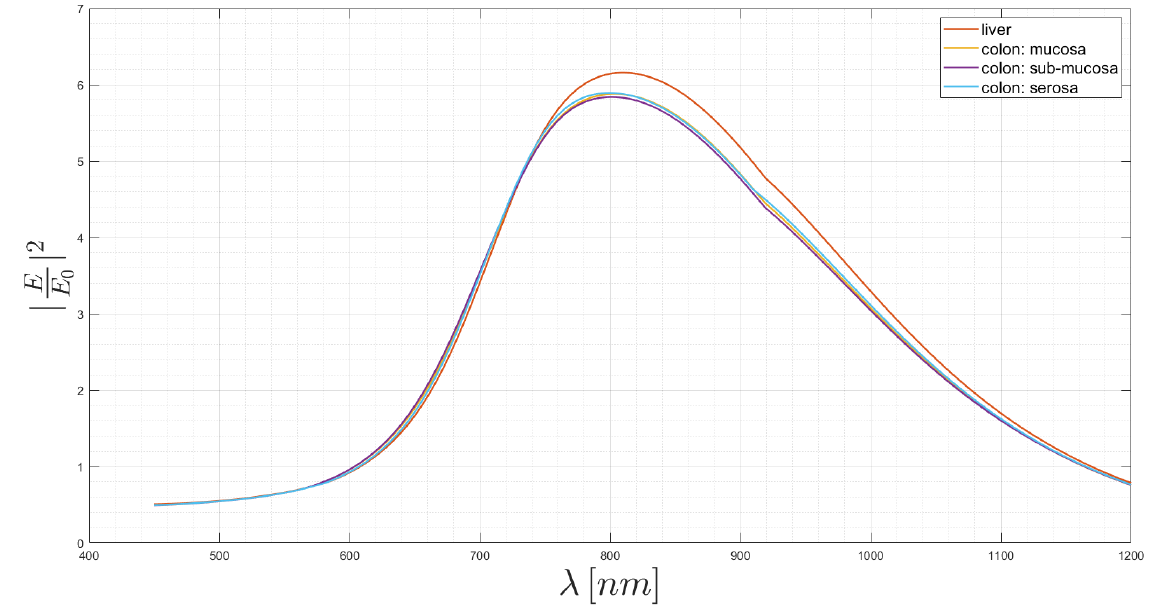
Figure 17. Gold nanostructure response for different human body tissues.